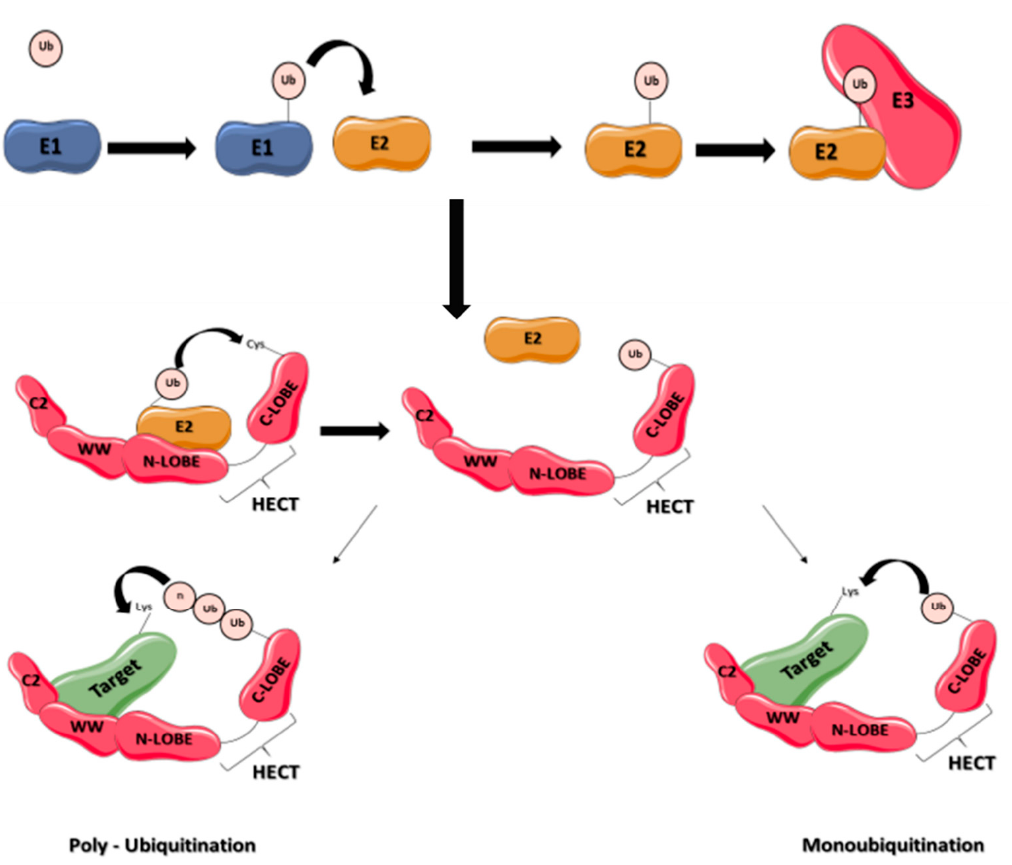
Figure 1. Schematic representation of ubiquitination process by E3 ligases containing HECT domain. Ubiquitin is activated by an enzyme E1 and then transferred to E2 enzymes, and to a HECT E3 enzyme. The E3 enzyme transfers ubiquitin to the target protein, leading to its monoubiquitination or polyubiquitination. The E3 ligase contains 3 domains, an N-terminal C2 domain, a WW rich domain and a C-terminal domain organized into two lobes (N-lobe and C-lobe).